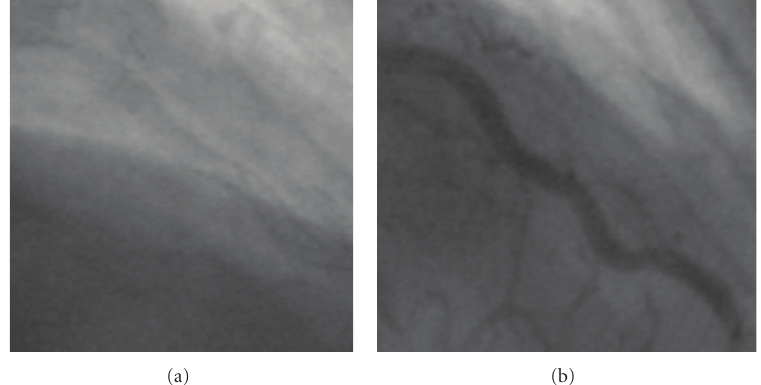
Figure 3: Angiographic images of the left anterior descending artery after two Xience V and one Promus stent deployment showing the absence of stent strut separation (a) and the presence of a good angiographic result (b).